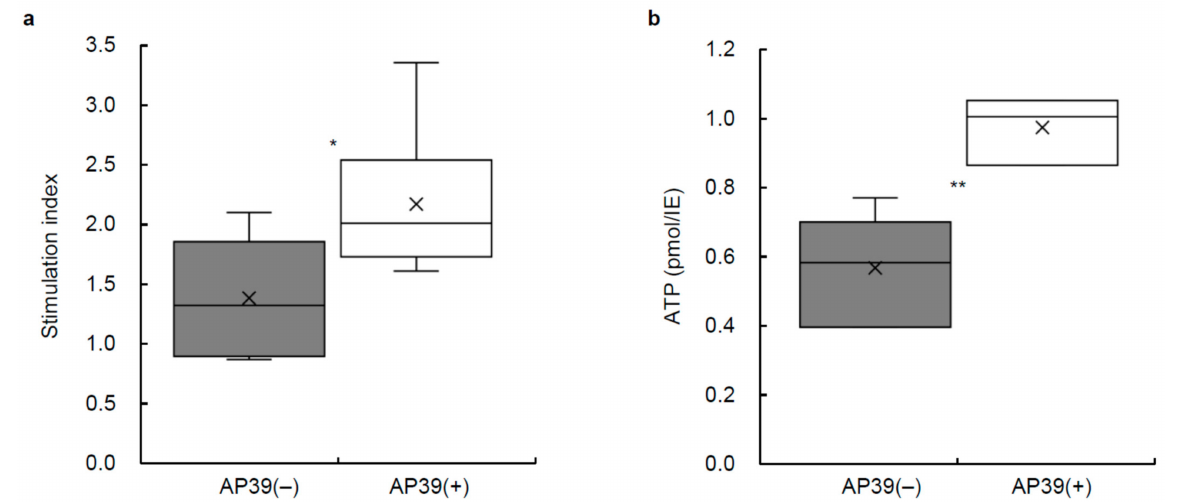
Figure 4. Stimulation index and ATP content of cultured islets with or without AP39. ( a ) The stimulation index was measured after 24 h islet culture in each group. AP39(+) and AP39( − ) groups: n = 6 each, * p < 0.05. ( b ) ATP content of cell lysates after 24 h islet culture was assessed using an ATP assay system. ATP content was normalized to DNA content. AP39(+) and AP39( − ) groups: n = 6 each, ** p < 0.01. Data are expressed as the mean ± SE.